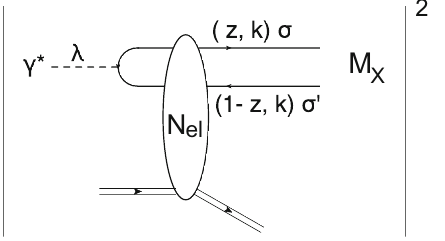
Fig. 5 The diffraction production of the quark-antiquark pair with mass M X . λ,σ and σ (cid:15) are photon, quark and antiquark helicities